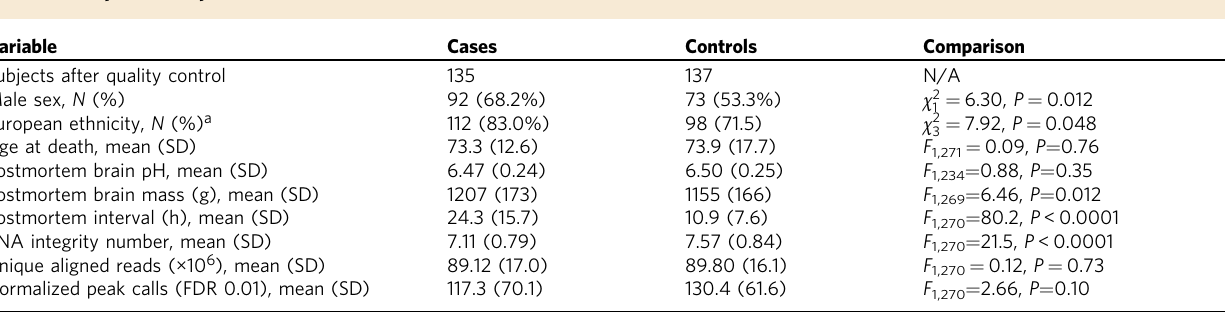
Table 1 Sample description